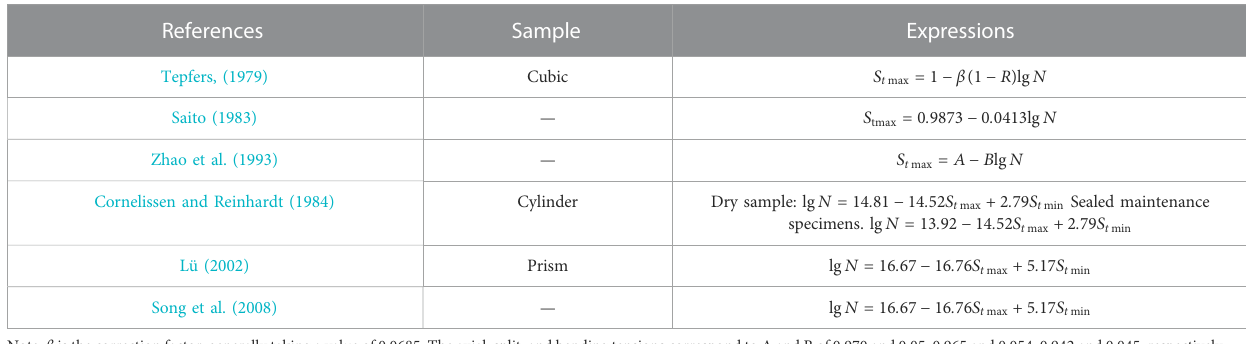
TABLE 2 Arrangement of fatigue equation of concrete under tensile condition.